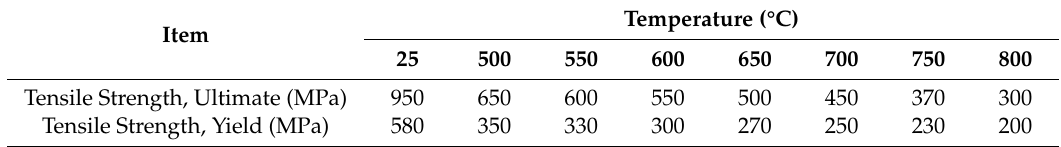
Table 3. Tensile Strength of 21-4N.